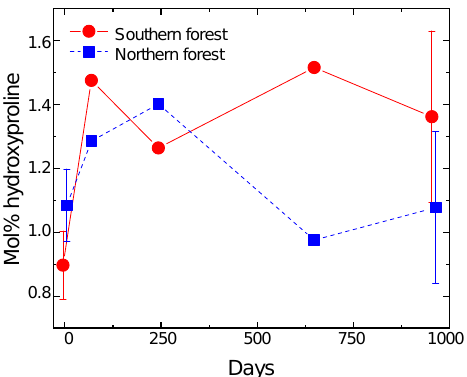
Figure 5. Hydroxyproline yields in the moss tissues as a percentage of total hydrolyzable amino acids. Error bars for the initial and final time points (0 and 959 days) indicate standard deviation ( n = 3). The initial and final time points are jittered ( ± 5 days) to display error bars without overplotting.